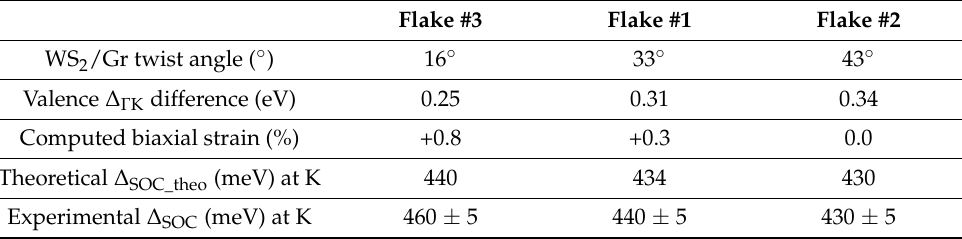
Figure 4. Structural and electronic properties of WS 2 under strain: ( a ) Band structures of WS 2 for different strains; ( b ) DFT calculations of the evolution of SOC under strain (PBE and HSE06, respectively). Table 1. Summary of 1 ML WS 2 /Gr flake properties: experimental twist angle (from ARPES); energy difference of the VBM ∆ Γ K ; corresponding computed biaxial strain (as determined from DFT); corresponding theoretical ∆ SOC_theo from PBE functional (reference value 430 meV at 0% strain); and experimental Δ SOC measurements.